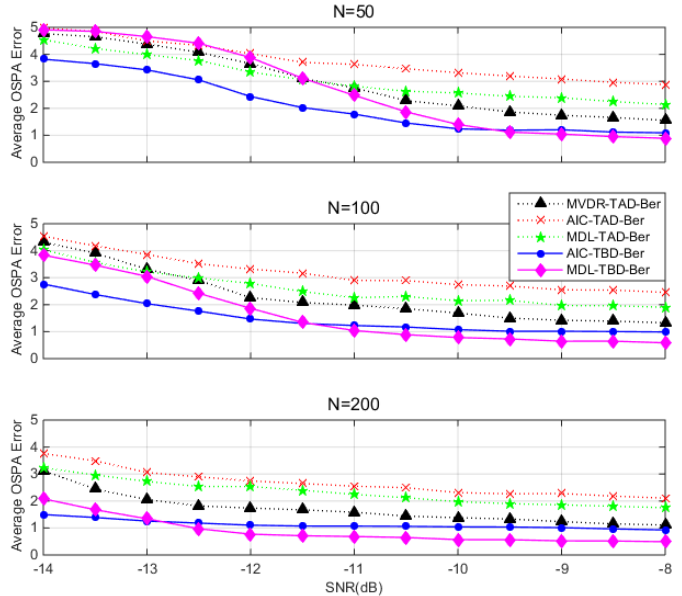
16 of 19 Figure 7. Detection performance for different methods (100 Monte Carlo runs) when SNR = −14 dB and number of snapshots 𝑁 = 50, 100, 200 . Figure 8 shows the average OSPA error versus different SNR via 100 trails. OSPA errors are averaged over time steps and 100 trails. It presents the superior performance of TBD-Ber filters compared to TAD-Ber filters. In the high SNR region, MVDR-TAD-Ber show a comparable performance when SNR is 8 dB since the detections become so accurate that the accuracy could catch up with TBD-Ber filters. MDL-TBD-Ber gives better performance when SNR > −10 dB . The performance of AIC-TBD-Ber is affected by overestimation errors and slightly worse than MDL-TBD-